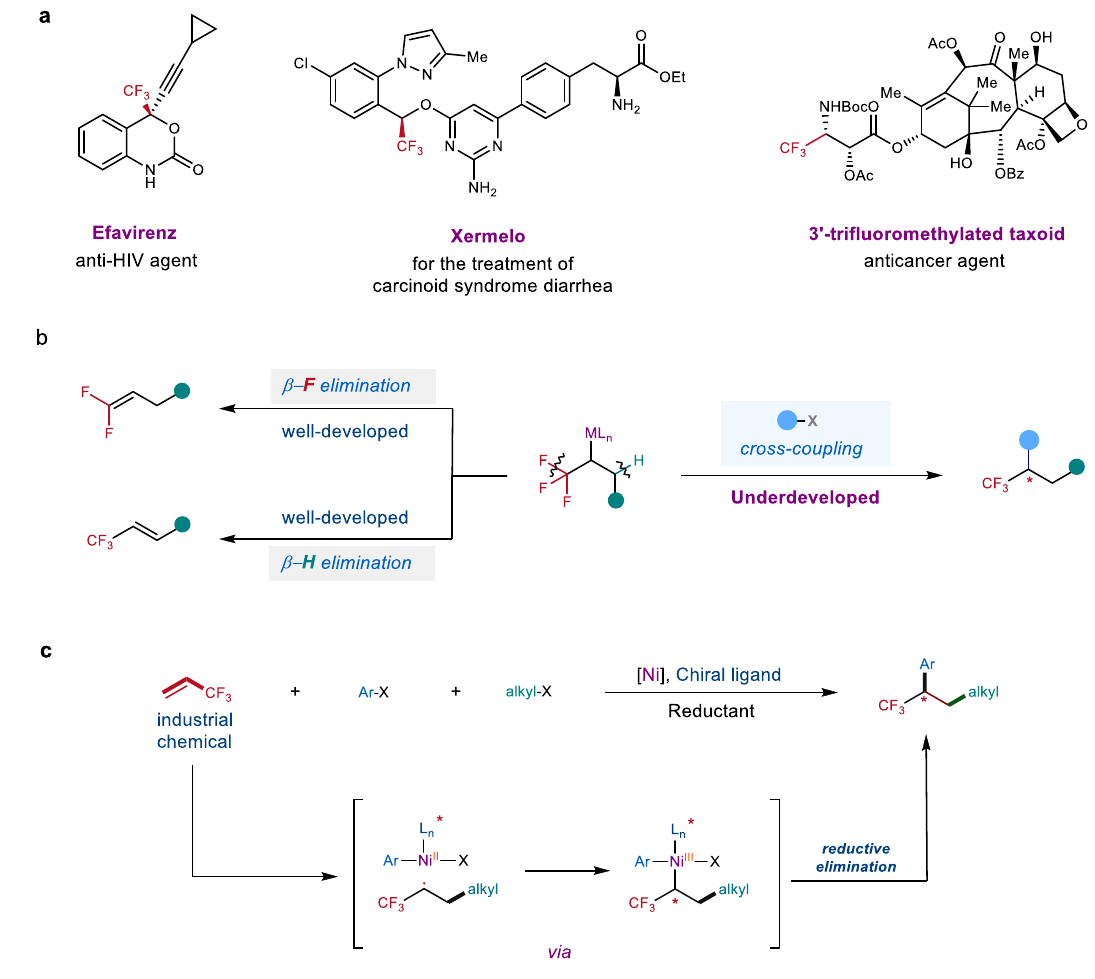
Fig. 1 | Nickel-catalyzed enantioselective dicarbofunctionalization of TFP and representative biologically active molecules bearing an α -CF 3 stereogenic center. a Biologically active molecules bearing an α -CF 3 stereogenic